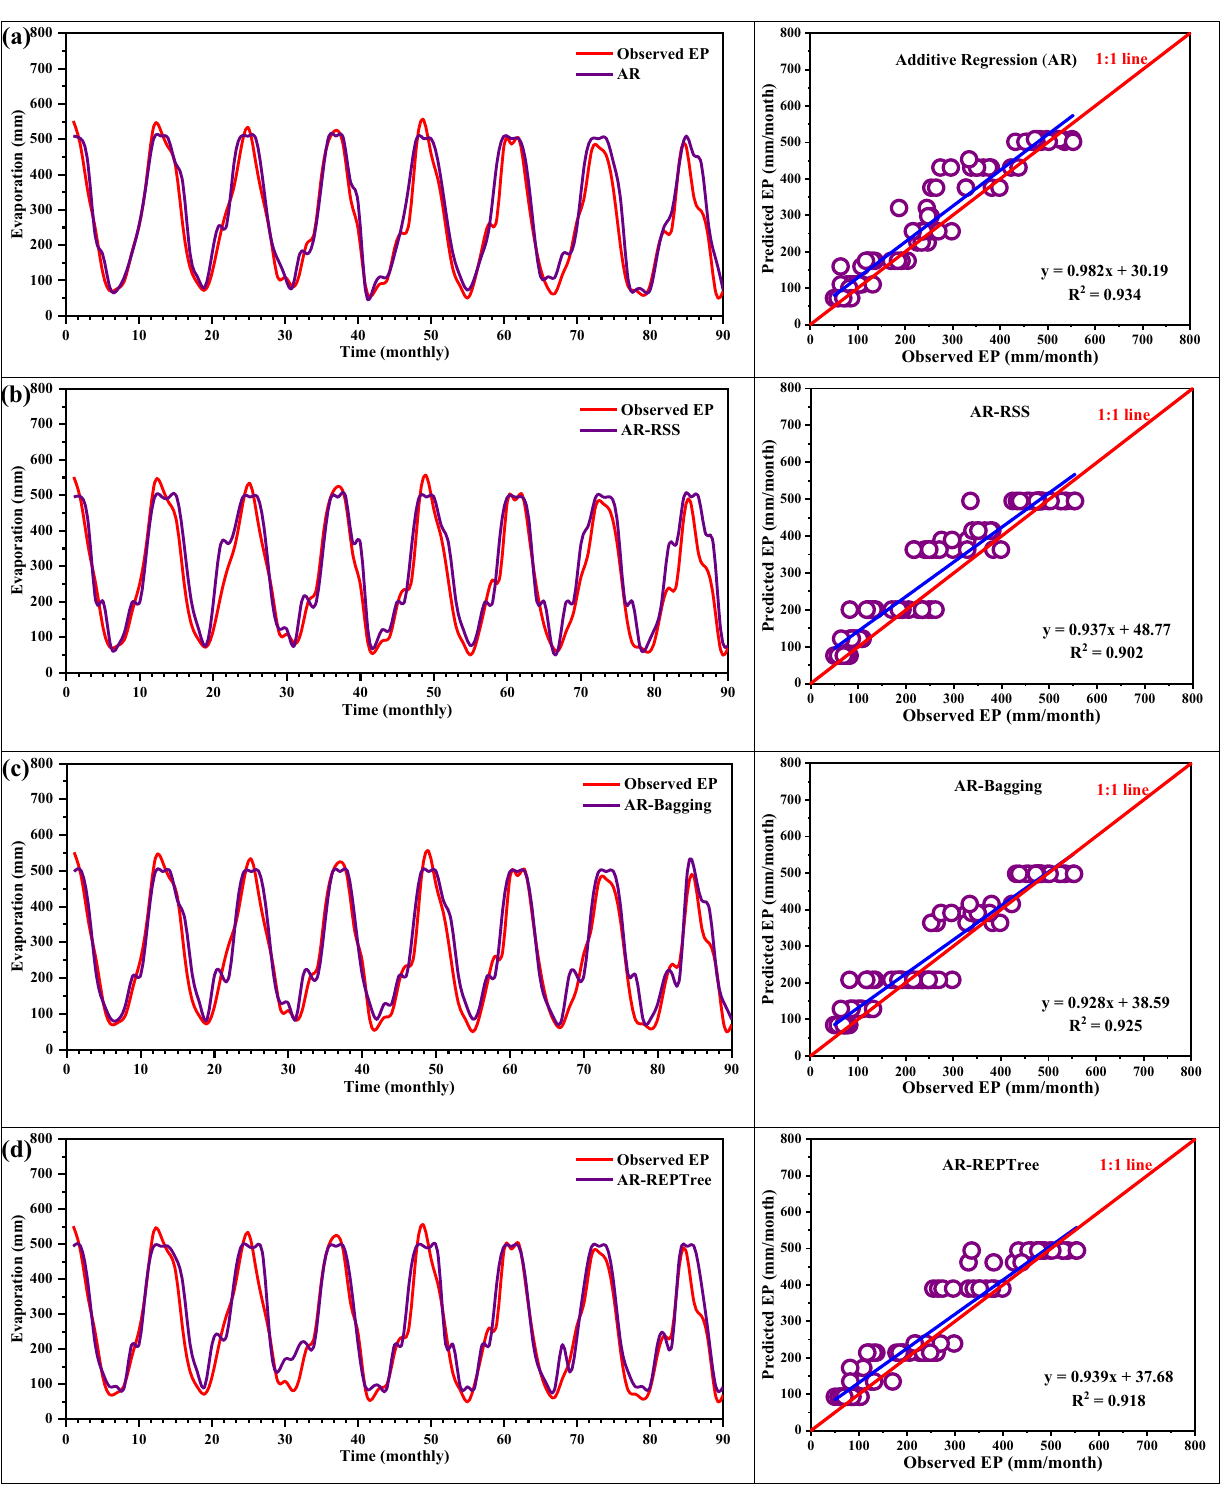
Fig. 5 Observed vs estimated daily evaporation values by the AR, AR-RSS, AR-Bagging, AR-REPTree, and AR-M5P models during testing at Baghdad